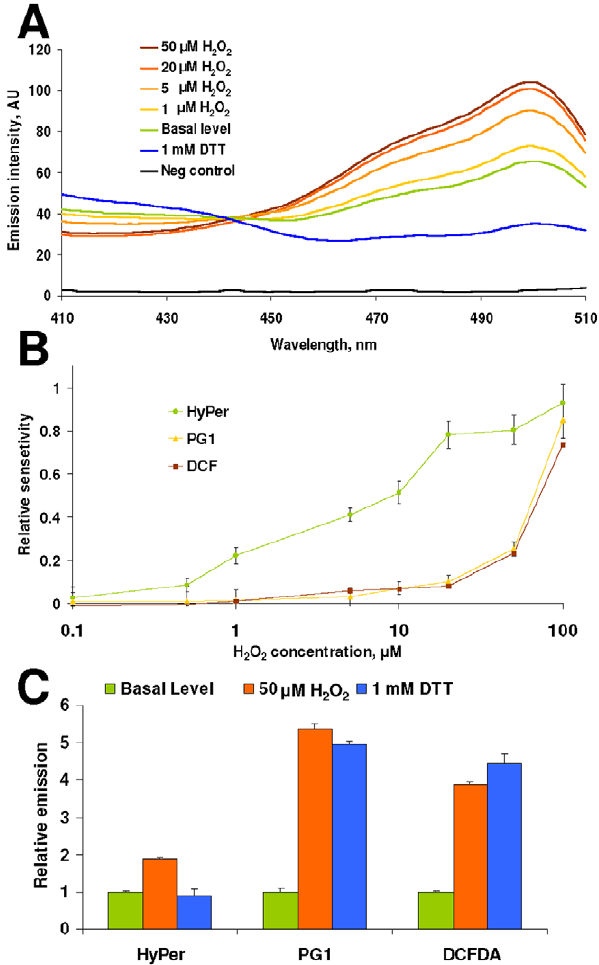
Figure 1. Response of HyPer expressed in HEK 293 cells to H 2 O 2 . (A) Fluorescence excitation spectra were recorded from HEK 293 cells expressing HyPer 3 min after indicated concentrations of H 2 O 2 were added to cells or 30 min after DTT treatment. Untransfected cells were used as a negative control. Emission was recorded at 530 nm. (B) Sensitivity of various peroxide sensors to H 2 O 2 treatment. Emission was recorded at 530 nm for HyPer and DCF and at 510 nm for PG1. (C) Probing H 2 O 2 with various fluorescent sensors in HEK 293 cells oxidized with H 2 O 2 (5 min) or reduced with DTT (30 min). All data represent mean of 3 measurements 6 standard deviation.